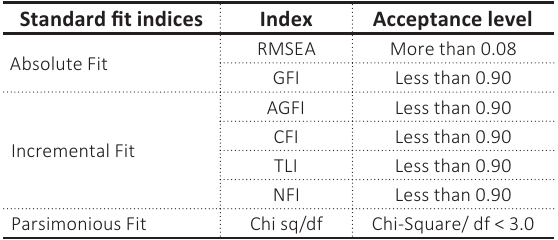
Table 3. Model fit categories